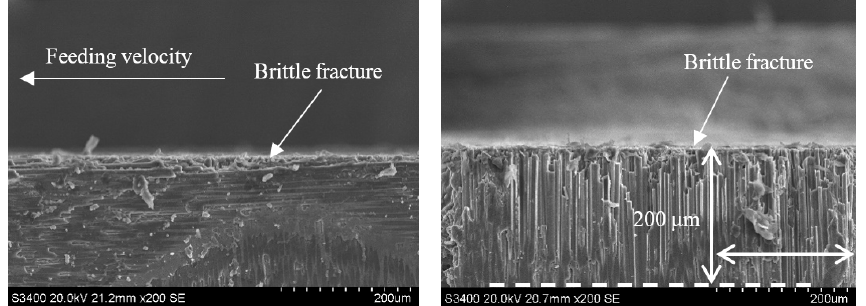
Figure 18. Grinding subsurface topography of the CG-C/SiC composite (v s = 1.26 m/s, a p = 0.4 mm, v w = 100 m/min).